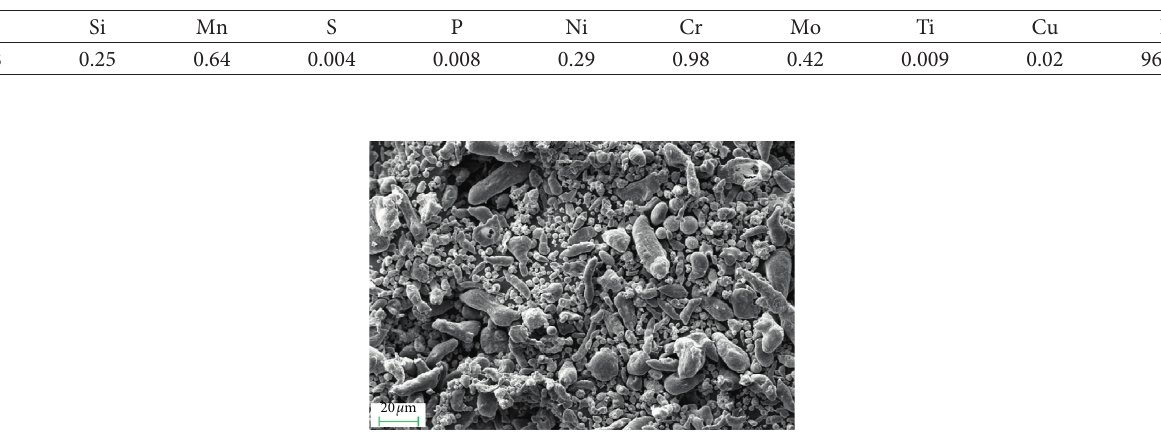
Table 1: Chemical composition of S135 steel (wt.%).